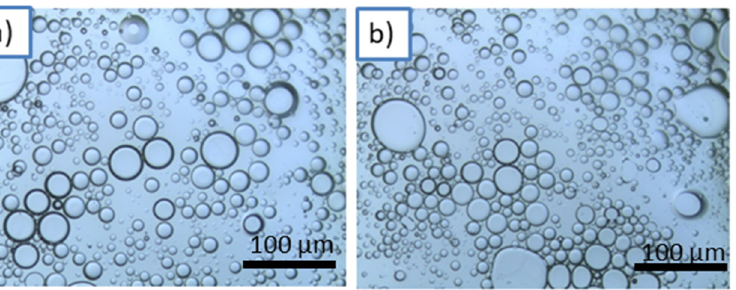
Figure 8. Images of droplets during atomization from a distance of 1 m: ( a ) with a ceramic filter and ( b ) with a plastic filter; ( c ) photo of the scale for a ×10 lens (distance between lines is 0.01 mm).